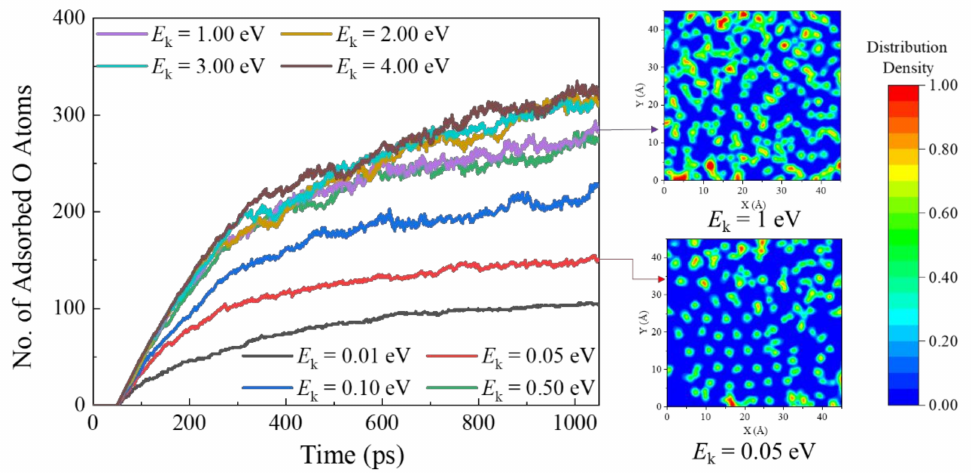
Figure 9. The effect of monatomic oxygen incident translational energy on the surface adsorption situation with snapshot illustrations of the saturated silicon dioxide surface by Models 1 and